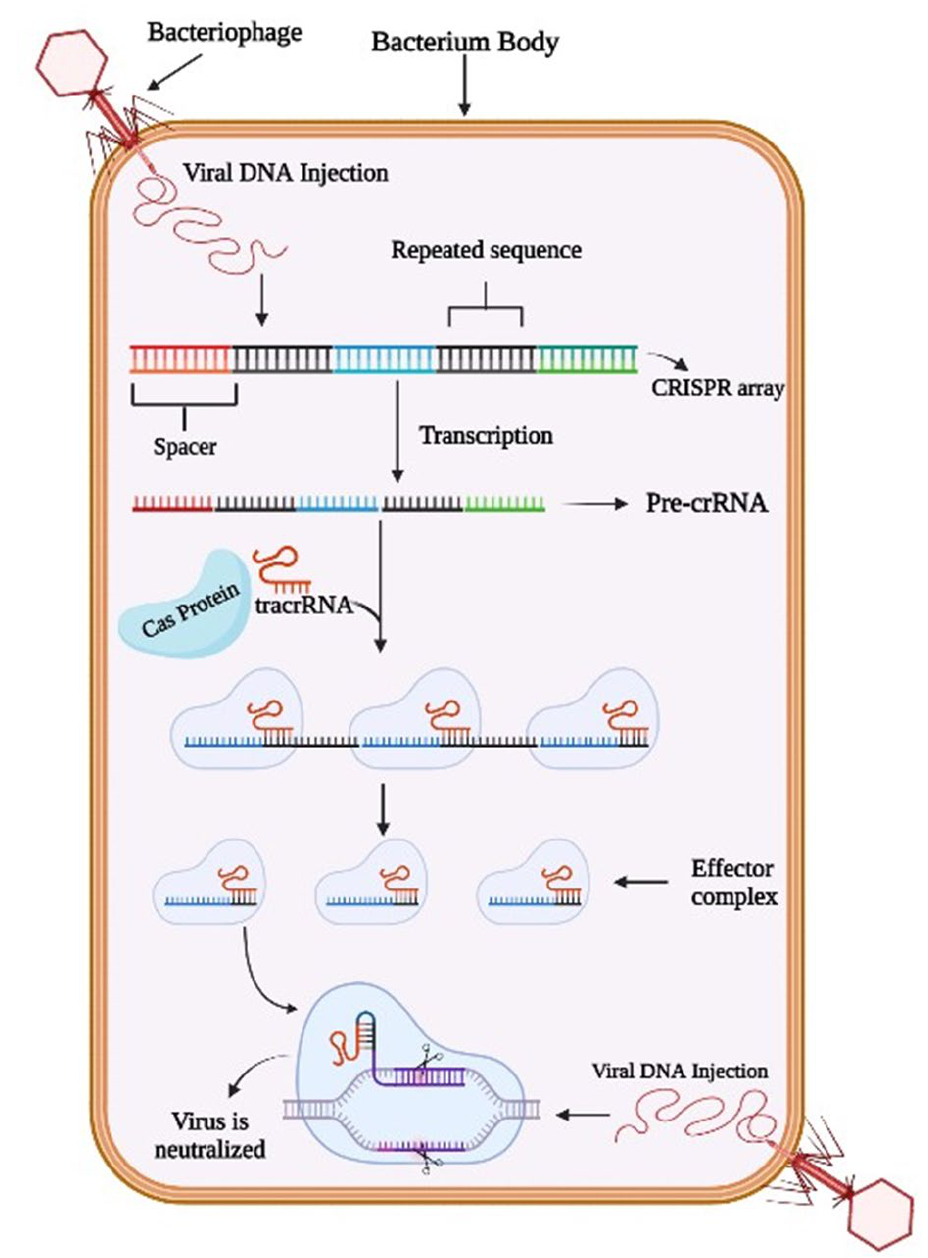
Figure 1. Mechanism of CRISPR-Cas against bacteriophage interference.